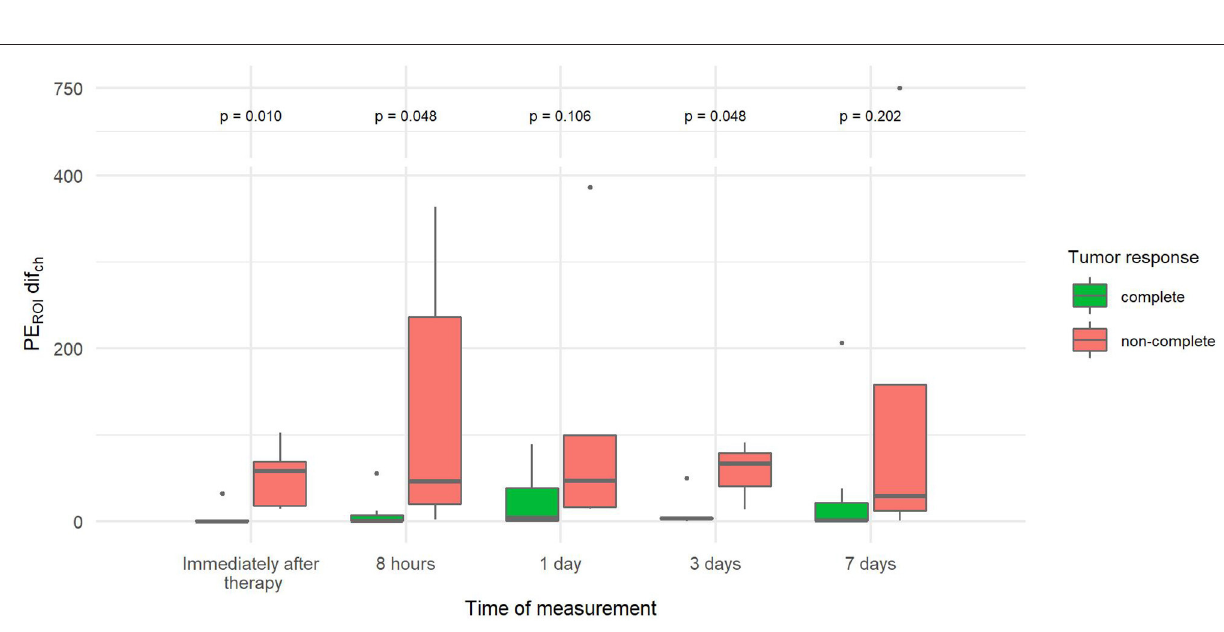
FIGURE 8 | Comparison of the percentage difference in change of peak enhancement of the two tumor parts (PE ROI dif ch ) at different time points between canine tumors with a complete and non-complete response to electrochemotherapy (ECT) with gene electrotransfer of plasmid DNA encoding interleukin IL-12 (GET pIL-12). Note the p -values presented at the top of the image. PE ROI dif ch is significantly lower for complete response tumors compared with non-complete response tumors immediately after therapy and at 8h and 3 days after